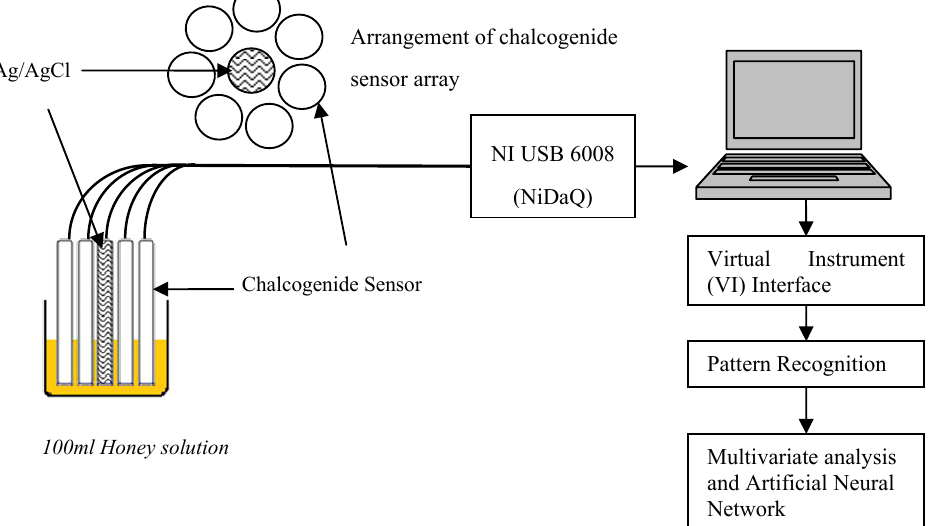
Figure 2. E-tongue setup for headspace evaluation of honey, sugar concentration and adulteration sample.